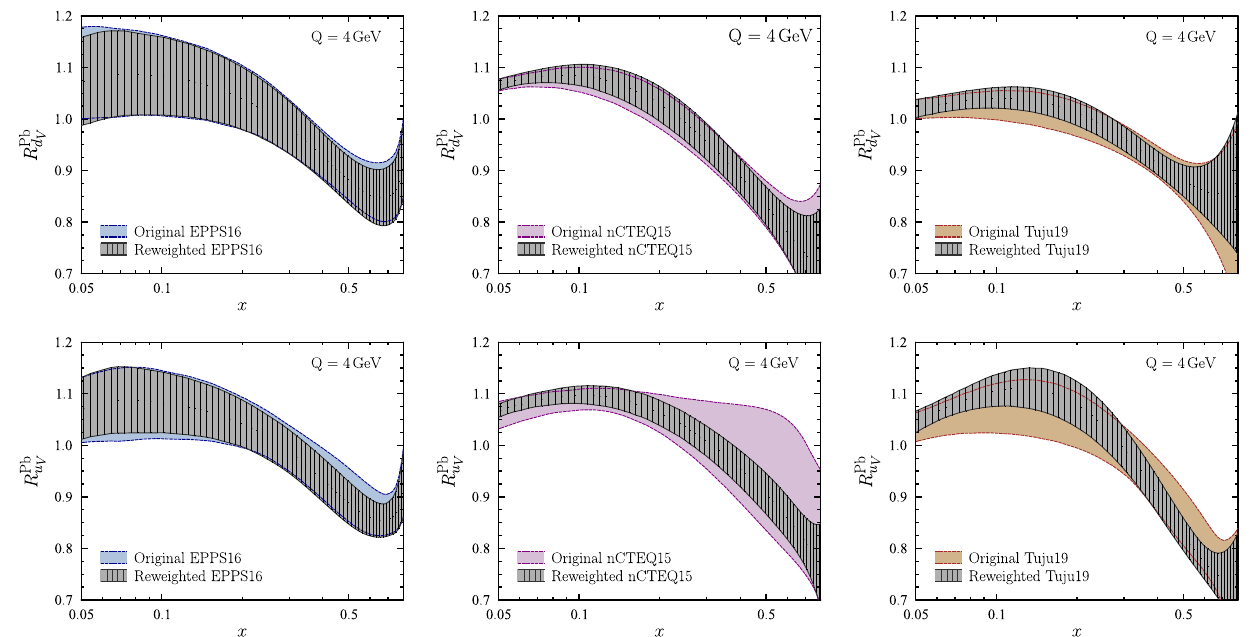
Fig. 5 Effect of re-weighting on nuclear modifications of down (upper row) and up (lower row) valence quarks in Pb at Q = 4 GeV. The coloured bands are the original uncertainty bands and the grey bands with hatching are the ones after